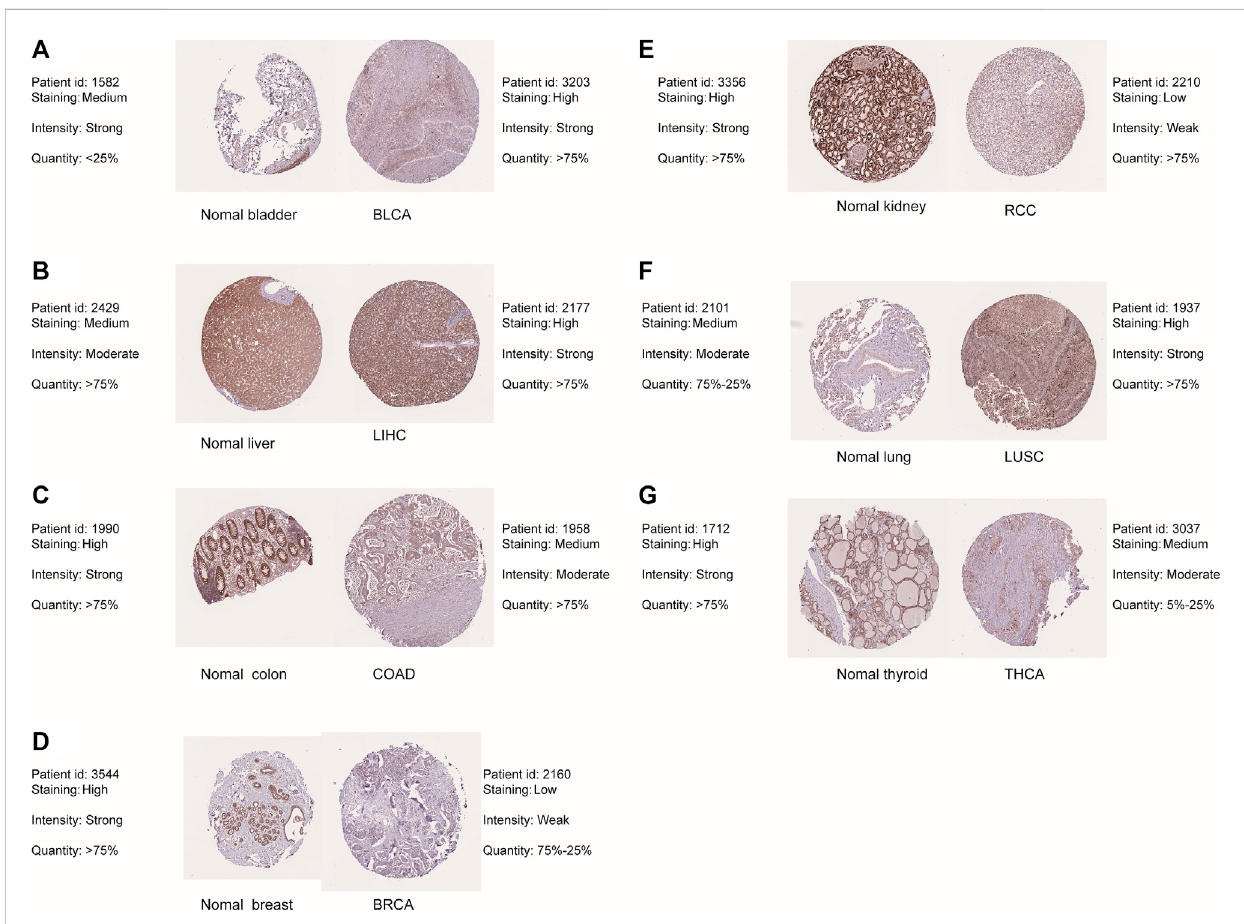
FIGURE 3 Differential expression of DLD between tumor tissues and corresponding normal tissues from the HPA database. (A) BLAC. (B) LIHC. (C) COAD. (D) BRCA. (E) RCC. (F) LUSC. (G) THCA.